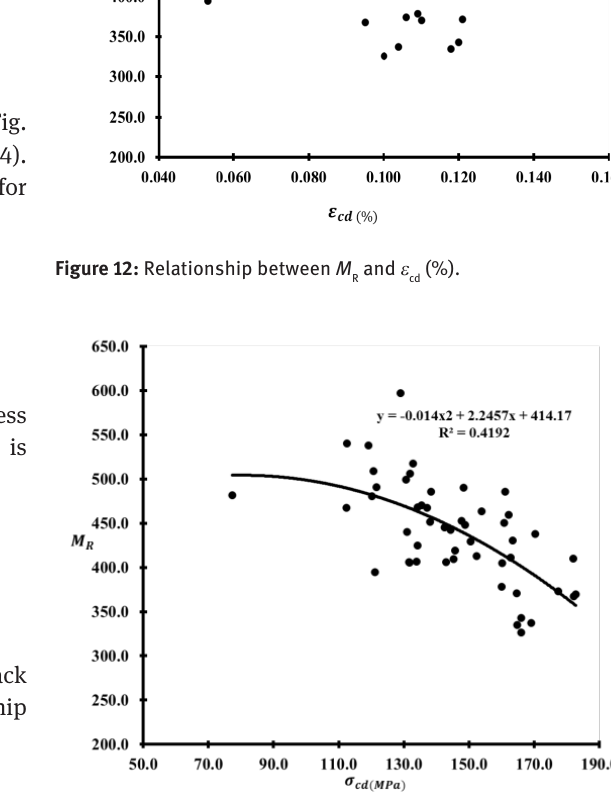
Fig. 12. Relationship between M